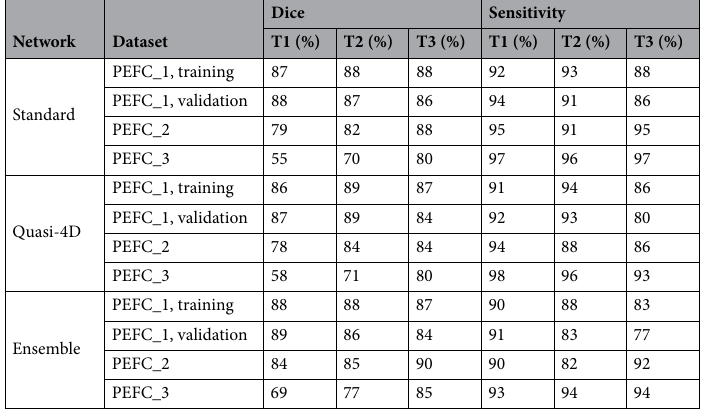
Table 1. Comparison of the classified water accuracy for the volumes at time steps T1, T2 and T3 computed between the SIRT-FBP-MD-D-DIFF and a manual segmentation (ground truth) for each MS-D network design and fuel cell dataset (PEFC_1 training and validation, PEFC_2, PEFC_3). The classified water accuracy was measured through dice coefficient and sensitivity throughout the volume.